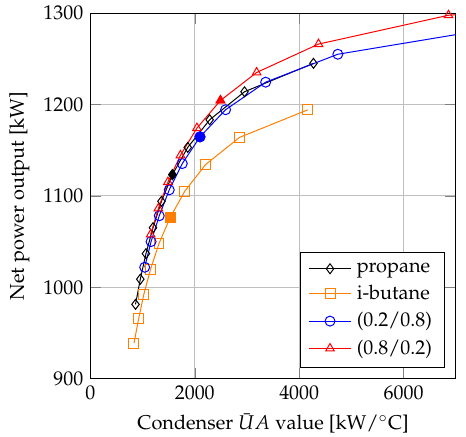
Figure 9. Net power output as a function of condenser ¯ UA .